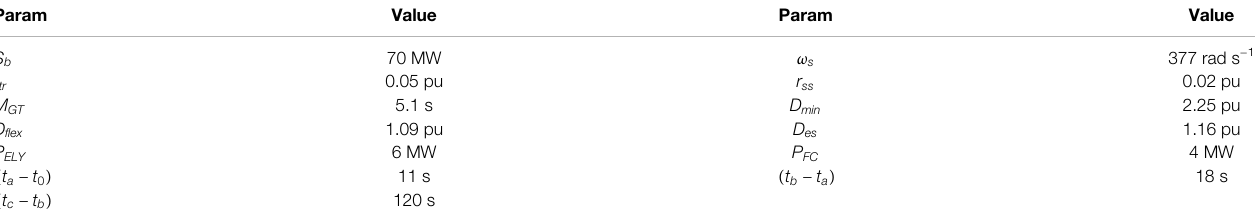
TABLE 1 | Parameters of the ACPS of an offshore oil and gas platform in the Norwegian continental shelf and the requirements for its converter-interfaced ESS. Param